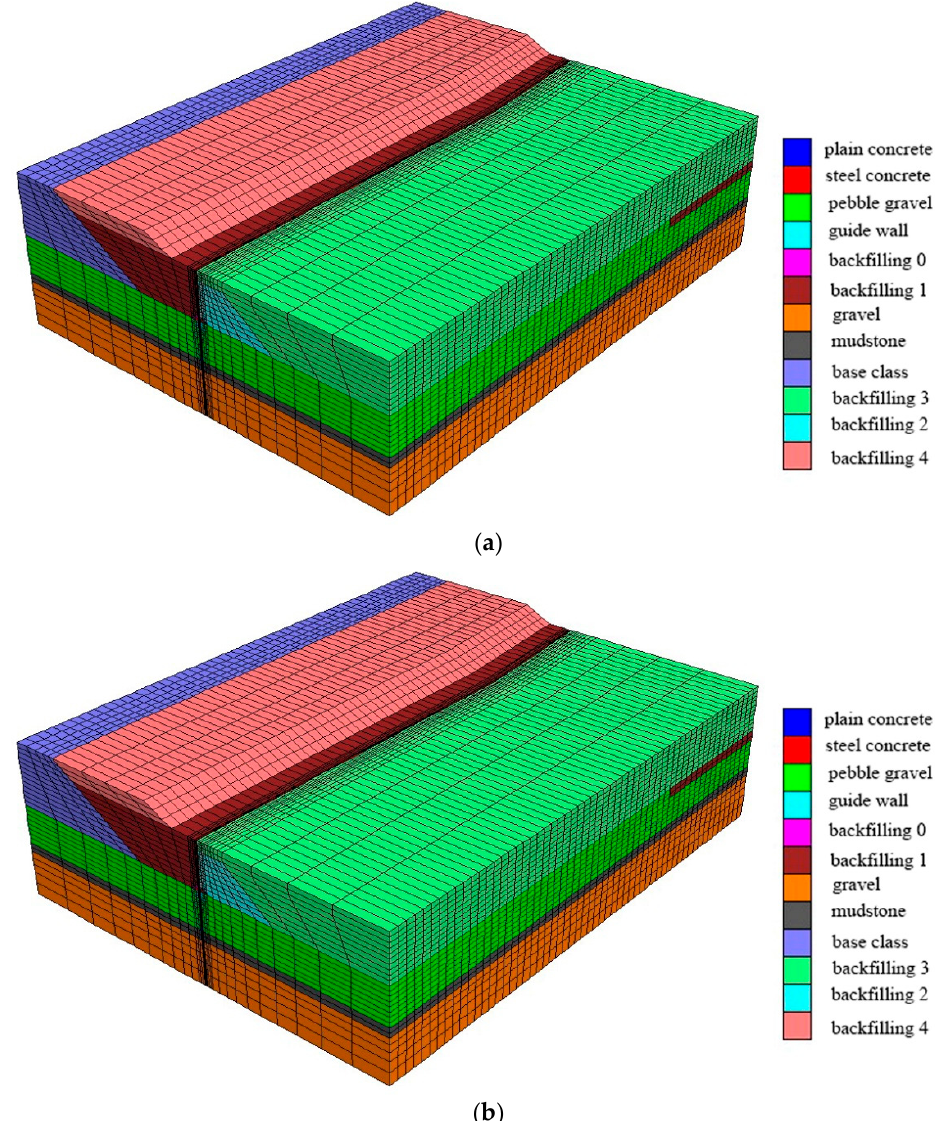
Figure 5. Three-dimensional cut-off wall model. ( a ) Meshing of 3D model. ( b ) Mesh division of cut-off wall.